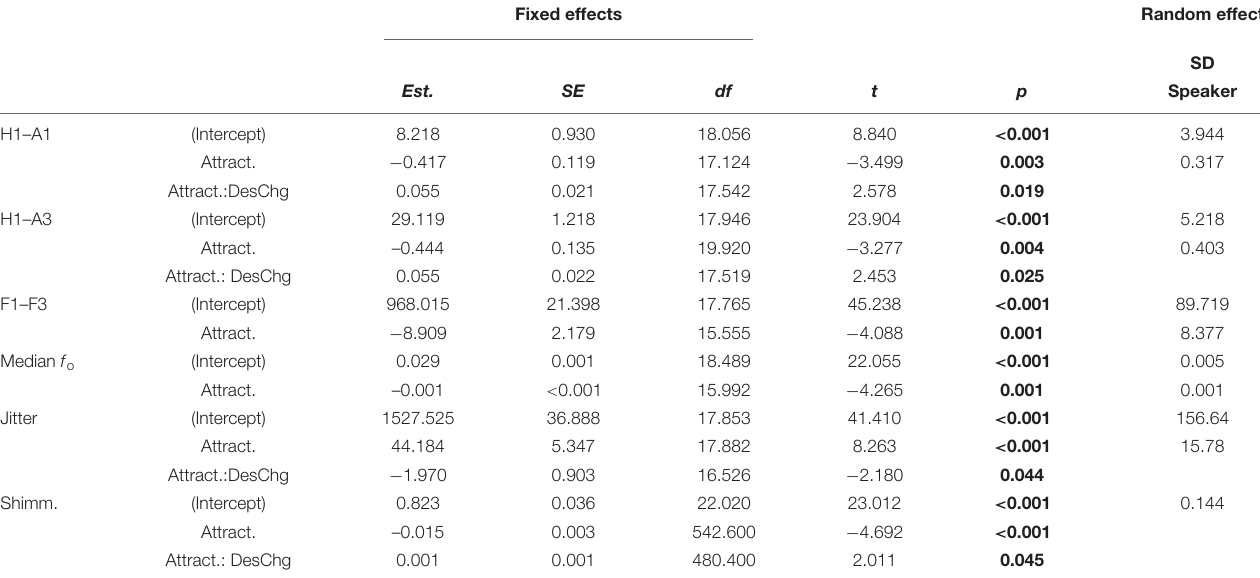
TABLE 2 | Model summaries for different acoustic